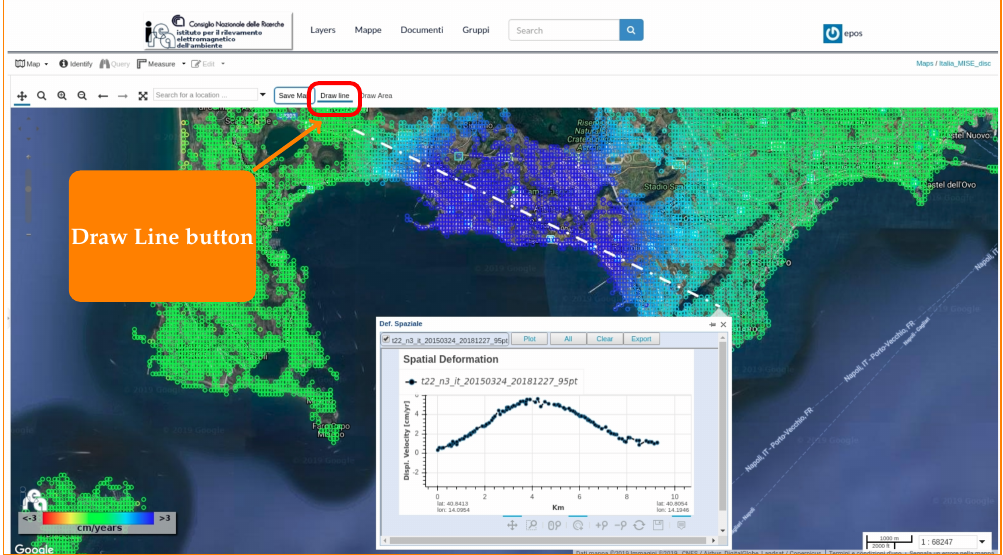
Figure 16. Example of the implemented mean deformation velocity cross-sections visualization and analysis